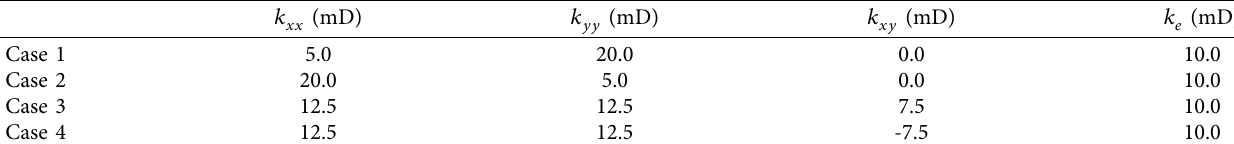
Table 4: Permeability tensors (zero-stress).